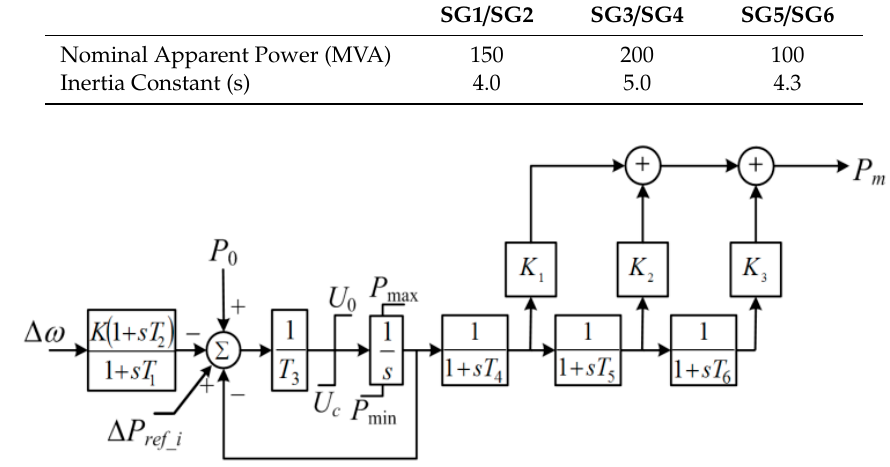
Figure 6. IEEEG1 model. Table 2. Parameters of the IEEEG1 model. Table 1. Parameters of Synchronous generators.